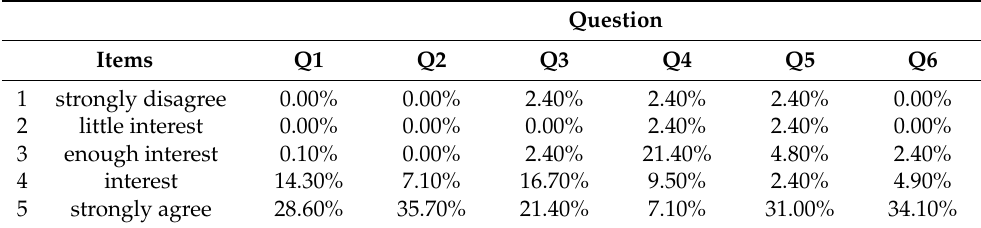
Table 8. The satisfaction level response proportion of boys < 12 years old (primary education).